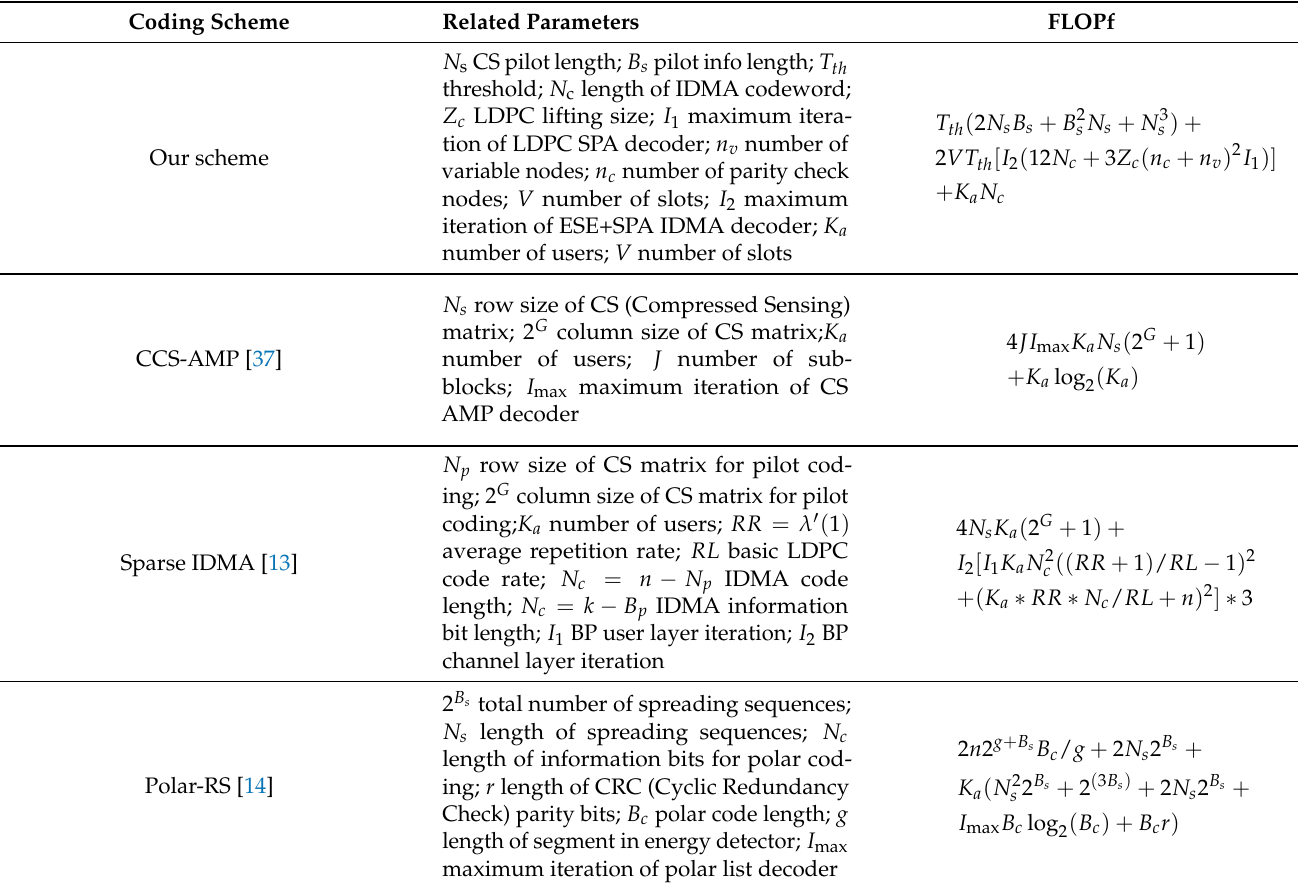
Table A1. FLOPf expressions of different coding